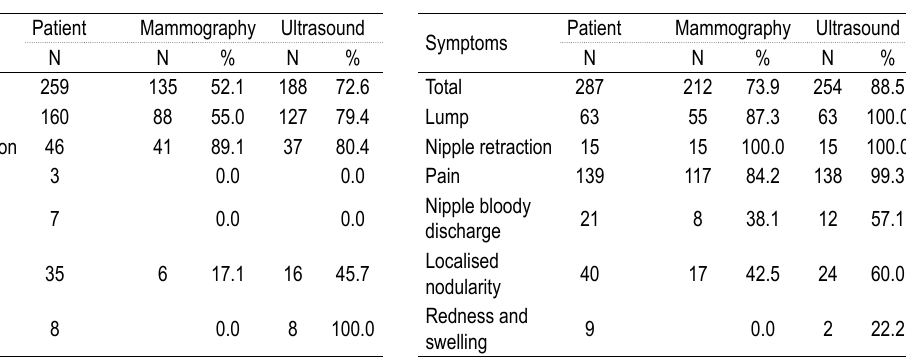
Table 7. comparative sensitivity of mammography and ul- trasound in breast cancer diagnosis according to symptoms